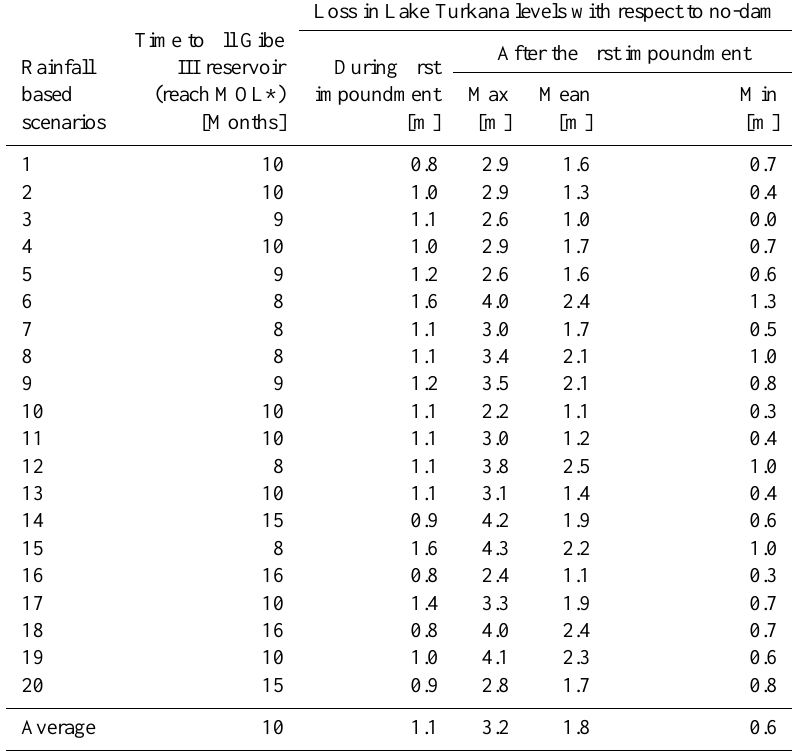
Table 3. Impact of the Gibe III dam on the Lake Turkana water level assessed using rainfall-based scenarios. Loss in Lake Turkana levels with respect to no-dam Time to fill Gibe After the first impoundment Rainfall III reservoir During first based (reach MOL*) impoundment Max Mean Min scenarios